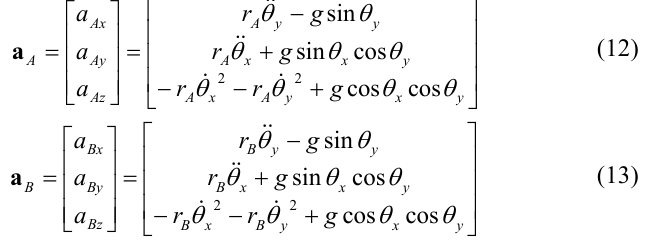
Fig. 3 Rotation of a rigid body with two triaxial accelerometers in 3D reference frame Based on Eq. (11), accelerations in each direction on a rigid body are known when it rotates in 3D reference frame. Then, how to estimate the orientation of the rigid body is the keystone. Suppose there was a rigid body with two triaxial accelerometers placed in 3D frame as Fig.3 shows. The two triaxial accelerometers were fixed coaxially at positions A and B on the rigid body, and the corresponding axes of the two accelerometers were in the same direction, then two groups of signals a could be obtained as , a A B